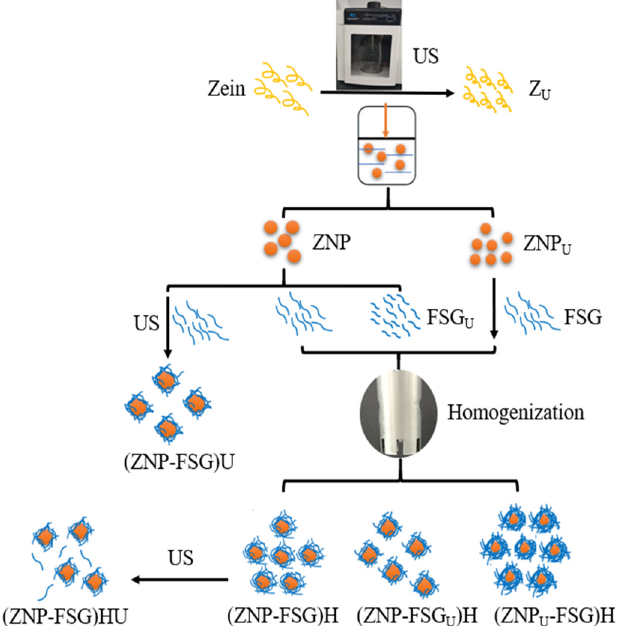
Figure 1. Overall schematic diagram of 11 various preparation routes, such as ultrasonicated zein (Z U ), zein nanoparticles (ZNP), ultrasonicated zein nanoparticles (ZNP U ), flaxseed gum (FSG), ul- trasonicated flaxseed gum (FSG U ), zein nanoparticles-flaxseed gum complexes by homogenization (ZNP-FSG)H, zein nanoparticles-flaxseed gum complexes by ultrasonication (ZNP-FSG)U, ultra- sonicated zein nanoparticles and flaxseed gum complex by homogenization (ZNP U -FSG)H, zein nanoparticles and ultrasonicated flaxseed gum complex by homogenization (ZNP-FSG U )H, ZNP-FSG by homogenization and ultrasonication (ZNP-FSG)HU. Table 1. The process of complex particles formation.